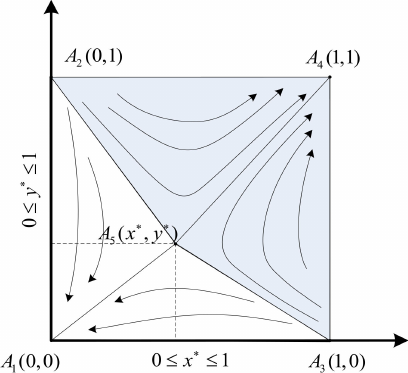
Figure 1. Dynamic of group replication between the public and